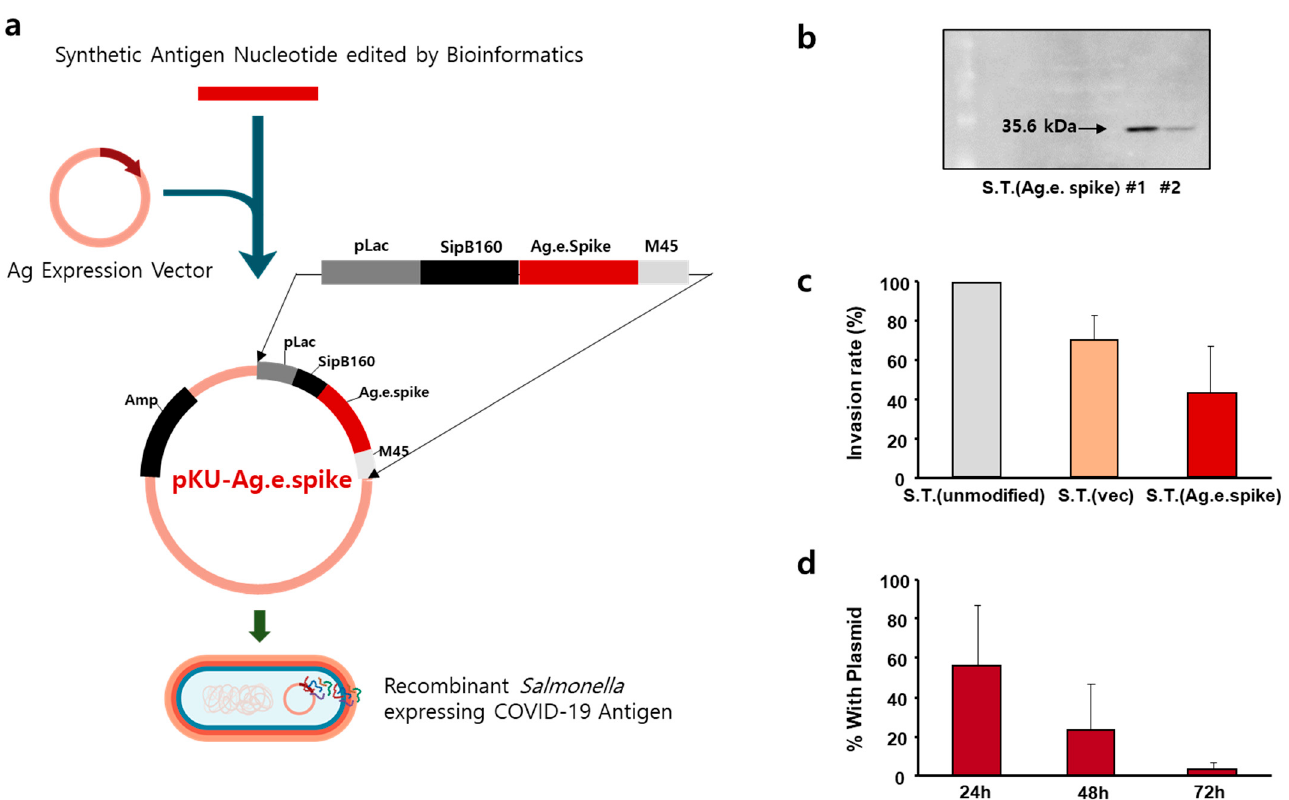
Figure 2. Construction of Salmonella Typhimurium expressing engineered spike protein as an antigen. ( a ) Schematic representation of the pKU-Ag.e.spike vector expressing engineered spike protein. ( b ) Expression of engineered spike protein in genetically engineered S. Typhimurium was measured by Western blot. ( c ) RAW 264.7 cells were infected with the indicated S. Typhimurium at a multiplicity of infection of 500:1 for 1 h (for invasion assay). The invasion rate of murine RAW 264.7 cells by the unmodified S. Typhimurium was set to 100%, and the relative internalization levels were normalized against those of unmodified S. Typhimurium. The data represent the mean ± standard error of three independent experiments. ( d ) Stability of pKU-Ag.e.spike in S. Typhimurium without antibiotic selection. Data represent the mean ± SD of a representative experiment.